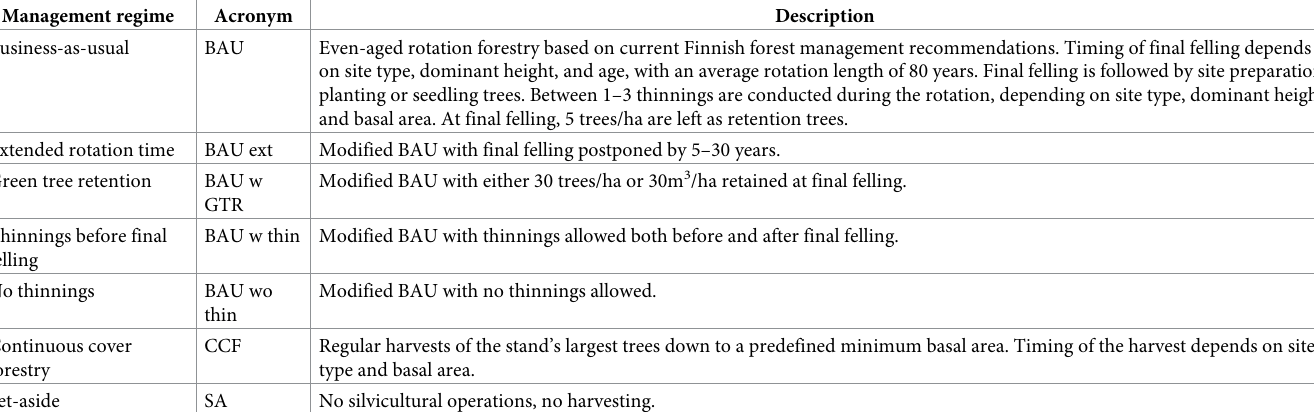
Table 1. Management regimes. The alternative management regimes applied in the forest growth simulations. For simplicity, the modified versions of ‘business-as-usual’ management have been grouped into 4 categories based on their defining features (extended rotation time, green tree retention, thinnings before final felling, or no